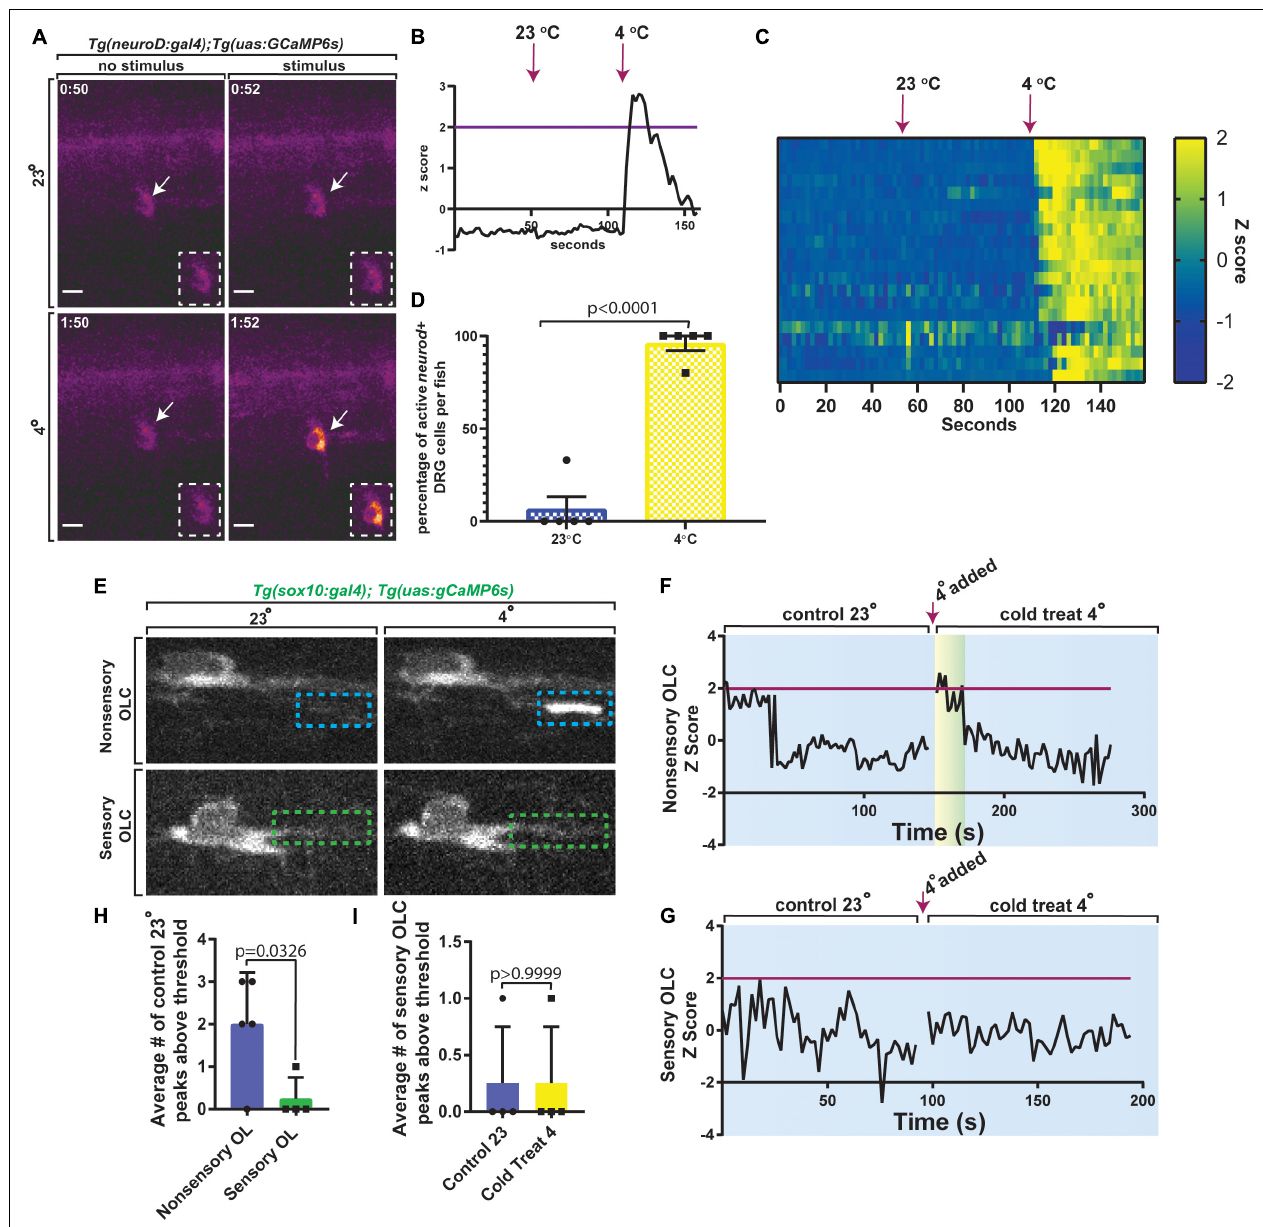
FIGURE 7 | Sensory-related OLCs display distinct Ca 2 + transients compared to non-sensory-related OLCs. (A) Images of Tg(neurod:gal4); Tg(uas:gCaMP6s) at 3 dpf showing calcium transients in DRG neurons after exposure to 23 or 4 ◦ C water. (B) Quantification of the Z Score of gCaMP6s intensity over time. Magenta line indicates Z score threshold above 2. Magenta arrow indicates the point at which 23 or 4 ◦ C water was added. (C) Heatmap representing each DRG neuron and the relative change in gCaMP6s intensity between exposure of 23 or 4 ◦ C water over time. (D) Quantification of the percentage of active DRG neuroD + cells per animal in 23 ◦ C control temperature compared to 4 ◦ C water ( p < 0.0001). (E) Images from a 3 min time-lapse in Tg(sox10:gal4); Tg(uas:gCaMP6s) zebrafish showing calcium transients in non-sensory-related OLCs compared to sensory-related OLCs upon exposure to 4 ◦ C water. Blue dashed boxes indicate the region of Ca 2 + transient activity in non-sensory-related OLCs. Green dashed boxes indicate lack of Ca 2 + transient activity in sensory-related OLCs. (F) Quantification of Z Score representing Ca 2 + transient activity in non-sensory-related OLCs upon exposure to 4 ◦ C water. (G) Quantification of Z Score representing the lack of Ca 2 ++ transient activity in sensory-related OLCs upon exposure to 4 ◦ C water. Magenta line indicates standard deviation threshold above 2 and magenta arrow indicates the point at which 4 ◦ C water was added in both F and G. Any peak above this magenta line indicates a positive peak value for calcium expression. (H) Quantification of the average number of control 23 ◦ C peaks above threshold in sensory-related OLCs versus non-sensory-related OLCs ( p = 0.0326). (I) Quantification of the average number of sensory-related OLCs peaks above the threshold in control 23 ◦ C versus 4 ◦ C water animals ( p > 0.9999). Scale bar equals 10 µ m (A,E) . All images are orientated anterior to left, posterior to right, dorsal up and ventral